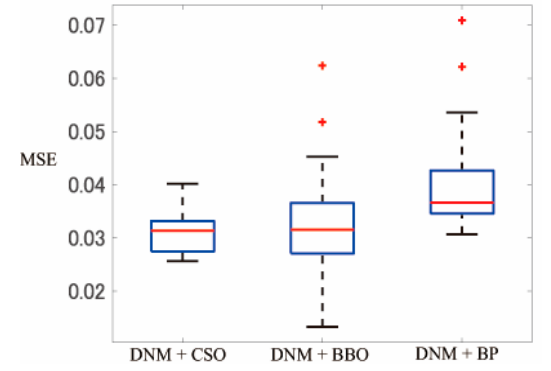
Figure 7. MSE of each method in F2.